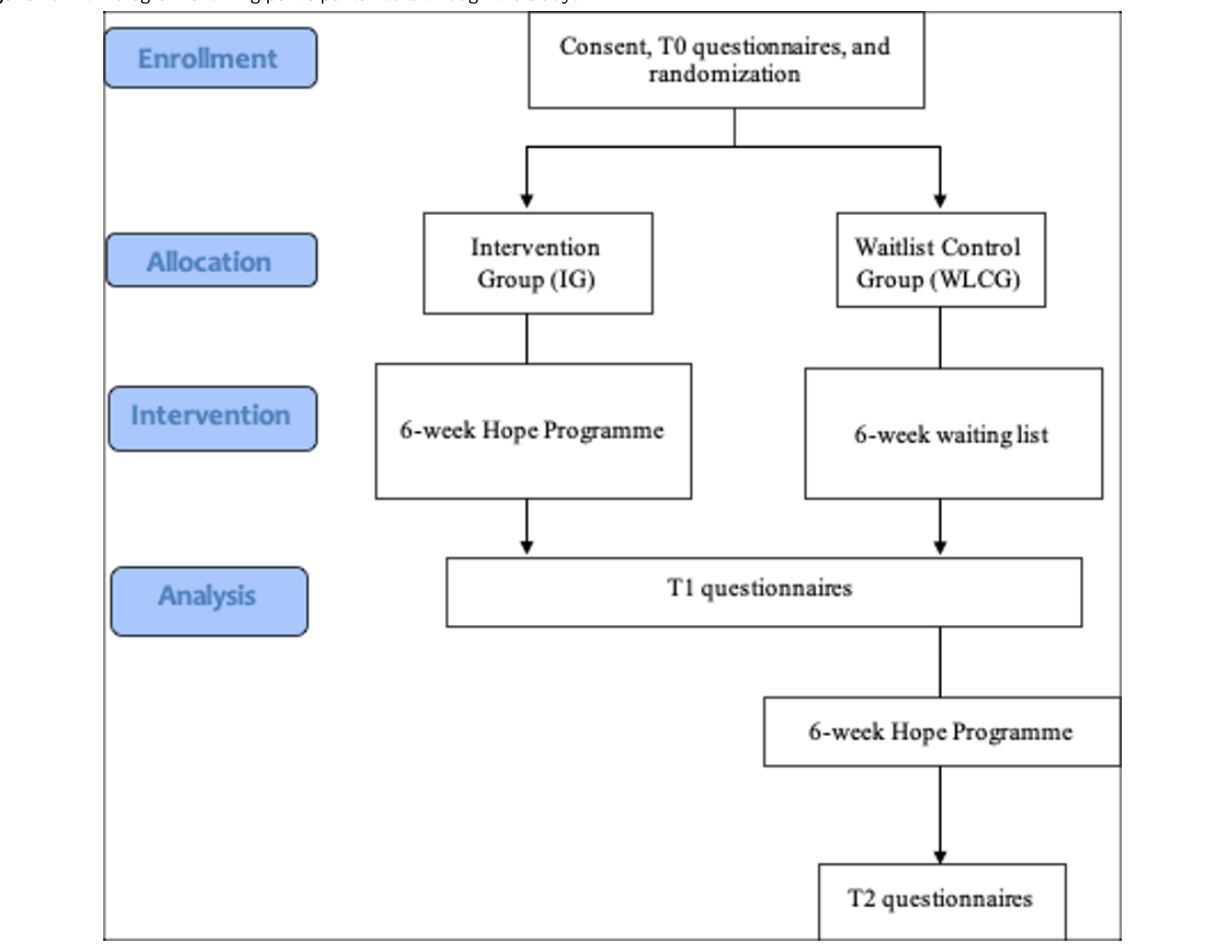
Figure 1. Flow diagram showing participants' route through the